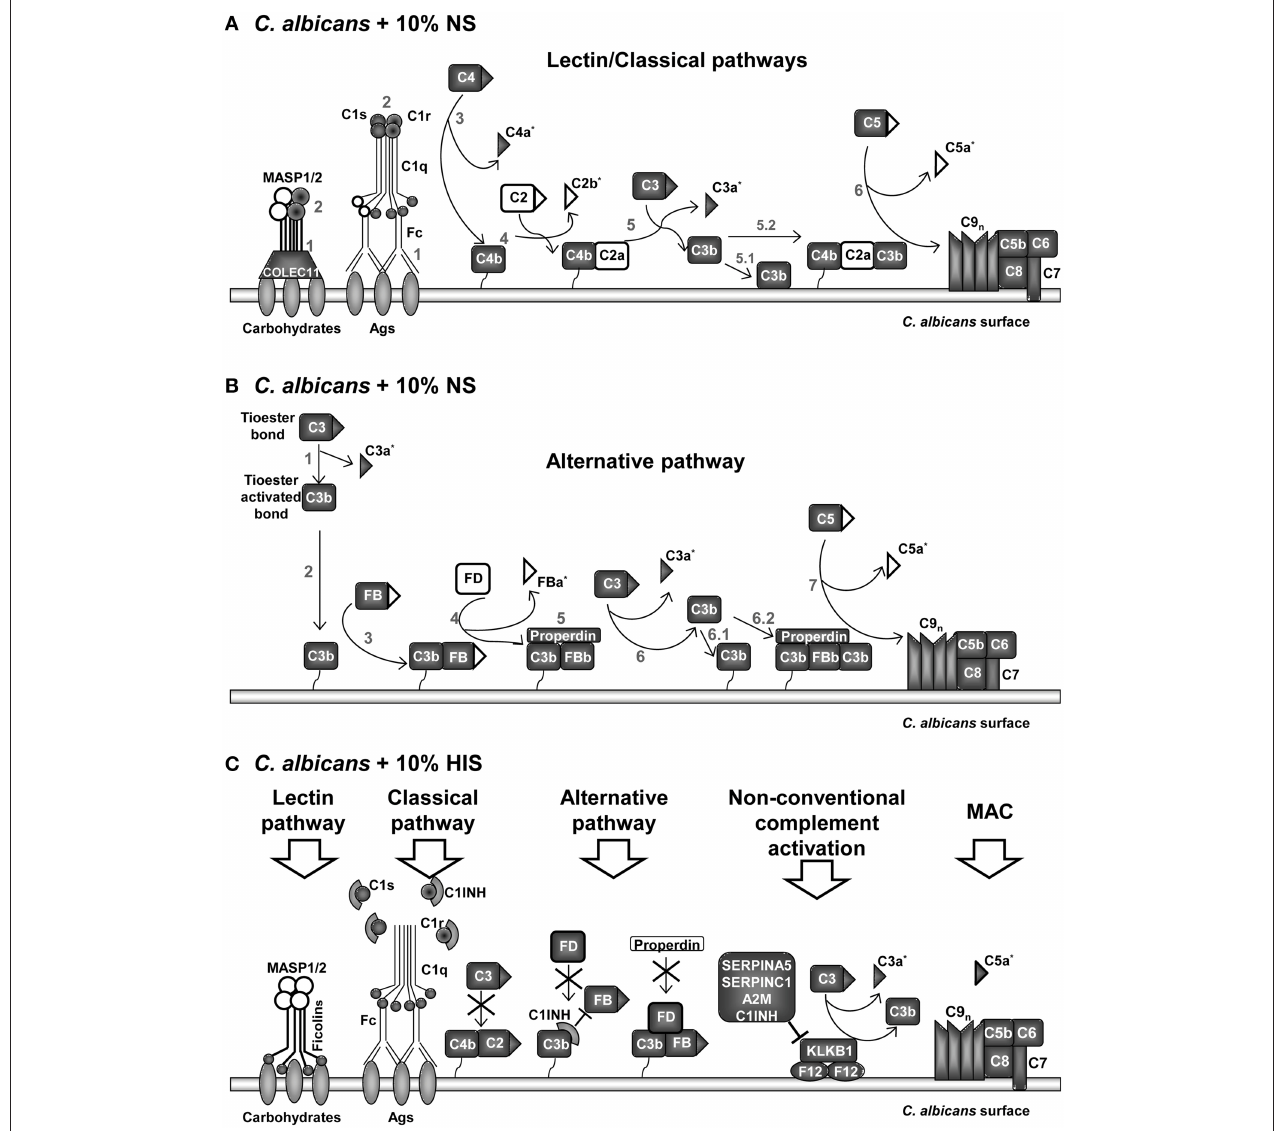
FIGURE 4 | Model of interactions among proteins of the complement pathways identified on C. albicans surface after incubation with human serum. Proteins identified in normal serum (NS) samples in (A,B) . Proteins belonging to lectin and classical pathways are represented in (A) and to alternative pathway in (B) . Proteins mainly identified on heat inactivated serum (HIS) in (C) . Identified proteins on samples are indicated with gray background and not-identified in white. Complement fragments released during complement activation are indicated with triangles. Peptides belonging to complement fragments that can be released or be part of a full-length protein are indicated with * . Numbers in (A,B) correspond to sequential steps during complement pathways activation. (A) Collectin-11 was only identified in NS samples. MASP2 was identified in NS and MASP1 was not identified in any sample. Fc (constant region of Ig) of IgGs or IgMs start classical complement pathway. (B) Properdin was identified in NS and Factor D (FD) was not. (C) Ficolin-2, Ficolin-3, C1qA, C1INH, and FD were identified only in HIS samples. C1INH dissociates the C1qrs complex, blocks alternative C3 convertase and inhibits C3 activation by kallikrein. C2 was identified in HIS, including 4 peptides of C2b. Five peptides belonging to FBa were identified in HIS condition. Signally, peptides belonging to C5a fragment were only identified in HIS samples.